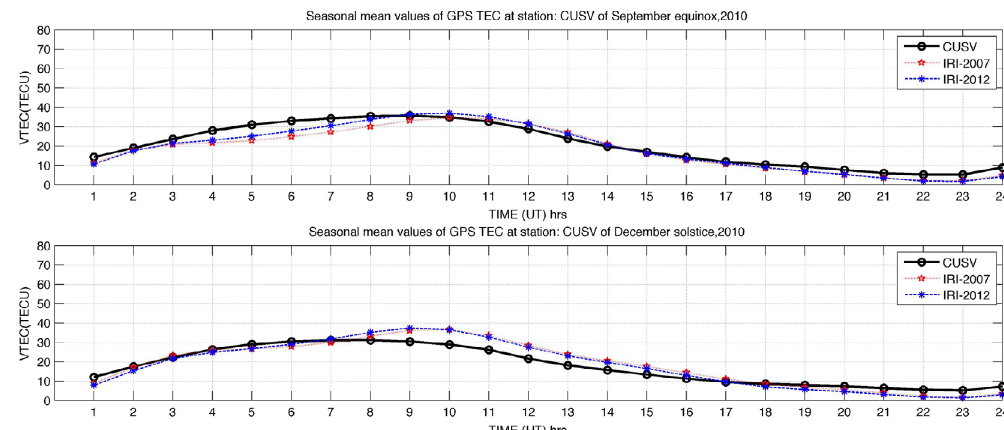
Figure 6. Seasonal mean values of GPS TEC, IRI-2007 TEC and IRI-2012 TEC at CUSV station during the period